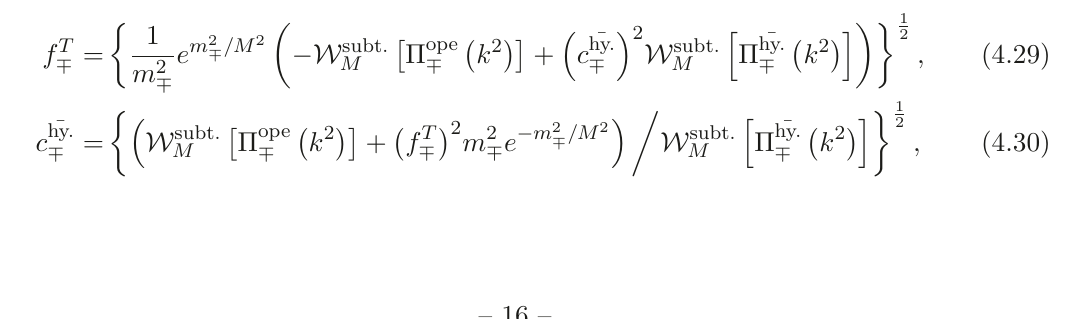
= 1 . 96 GeV 2 and (b,d) isovector parity-even channel (¯ b 1 ) 0